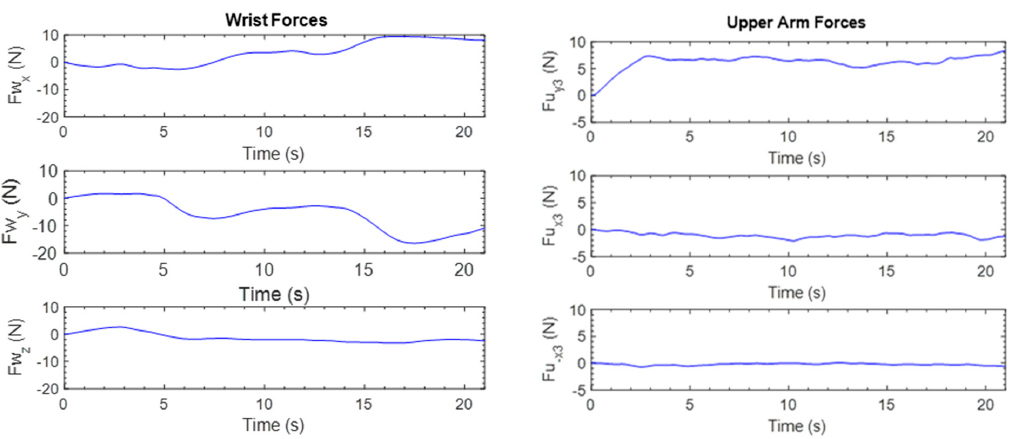
Figure 19. Subject’s forces during shoulder abduction and adduction.